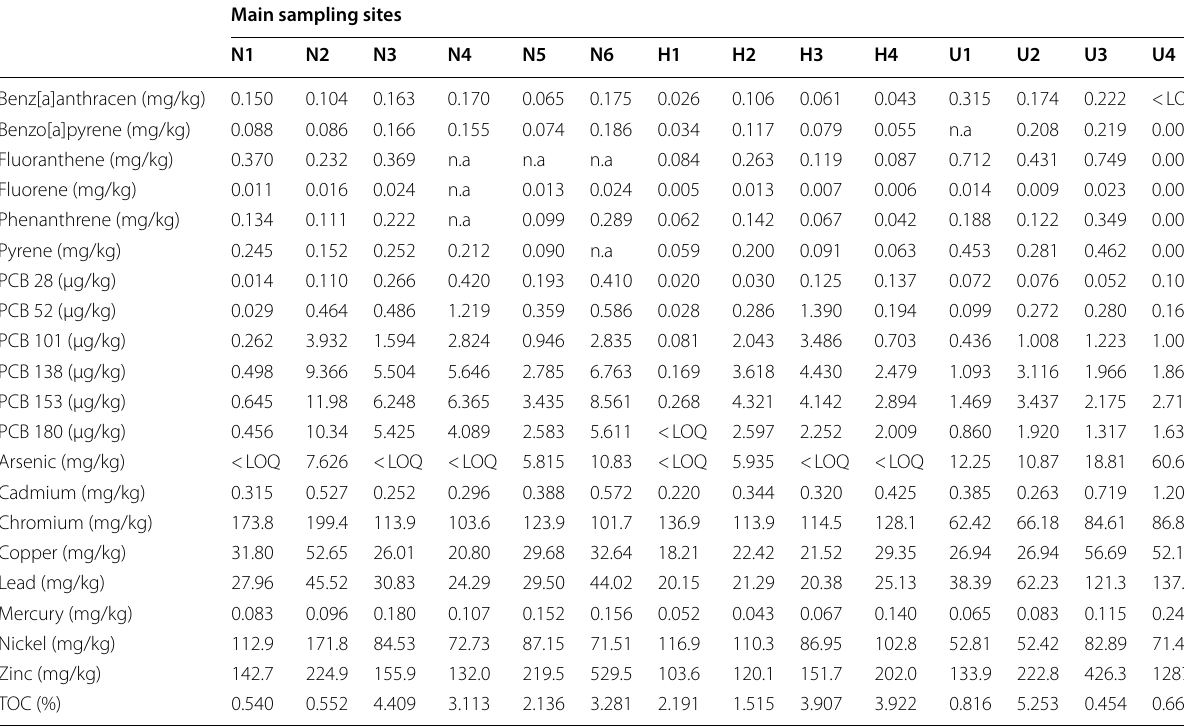
LOQ limit of quantitation, n.a not analysed